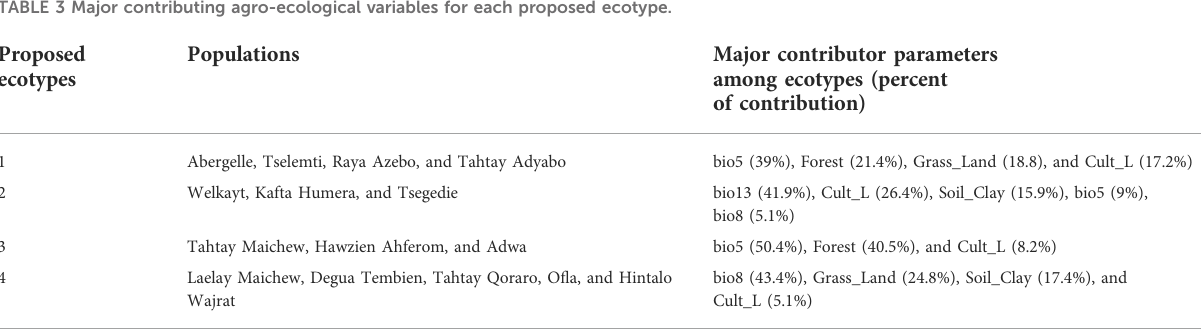
TABLE 3 Major contributing agro-ecological variables for each proposed